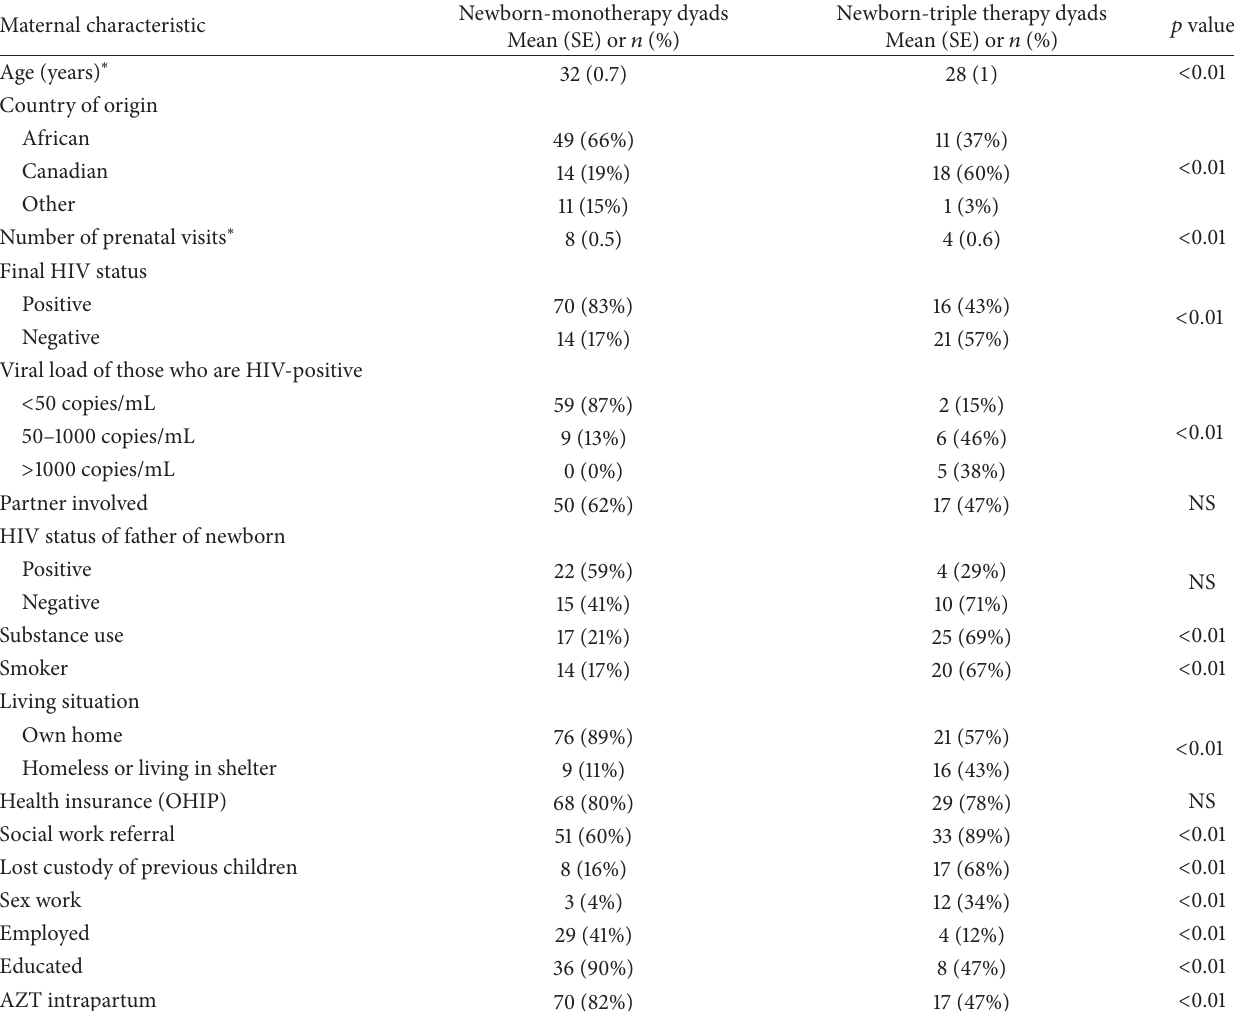
Table 3: Differences in maternal characteristics between newborn-monotherapy dyads and newborn-triple therapy dyads.